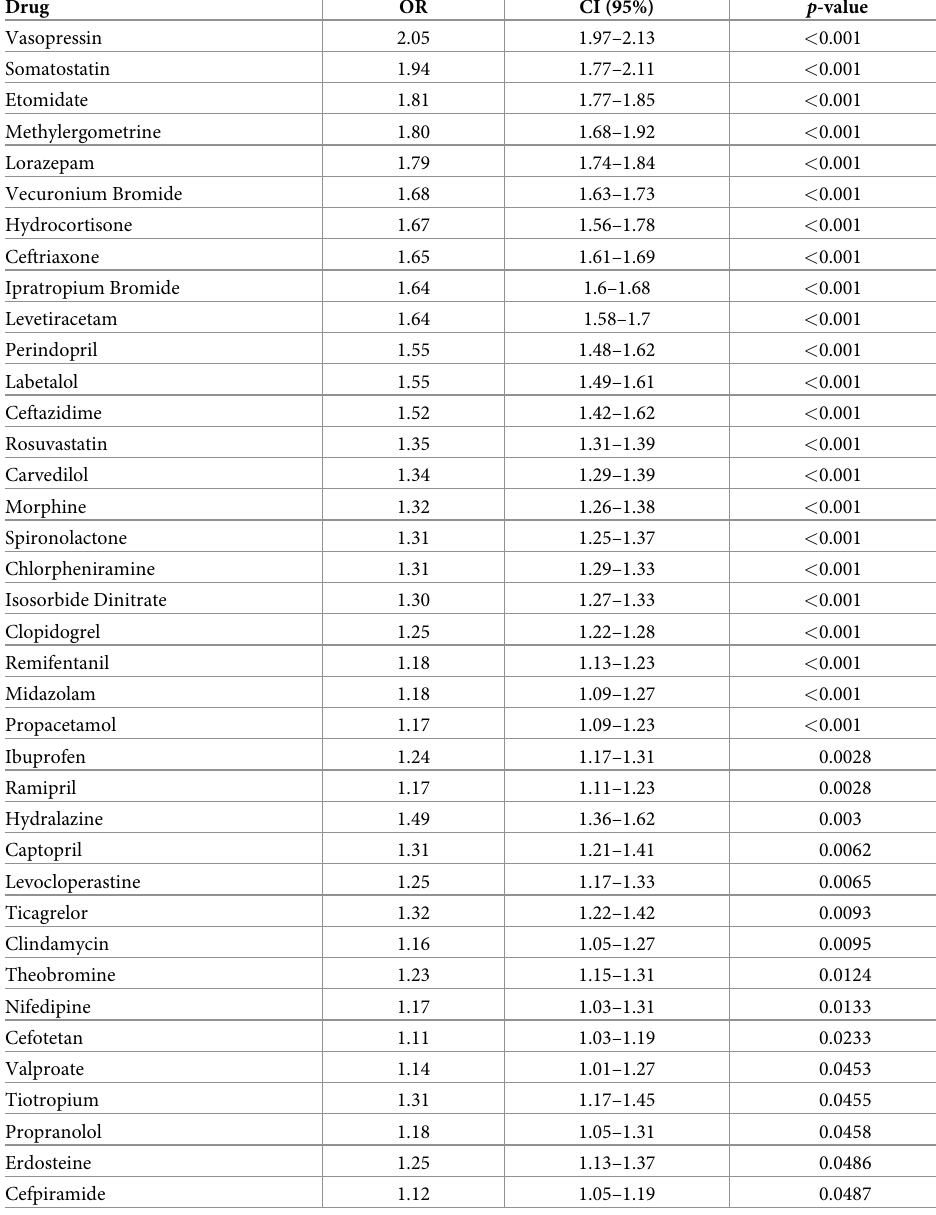
Table 2. Results of 38 rank 1 drugs with significant QT prolongation